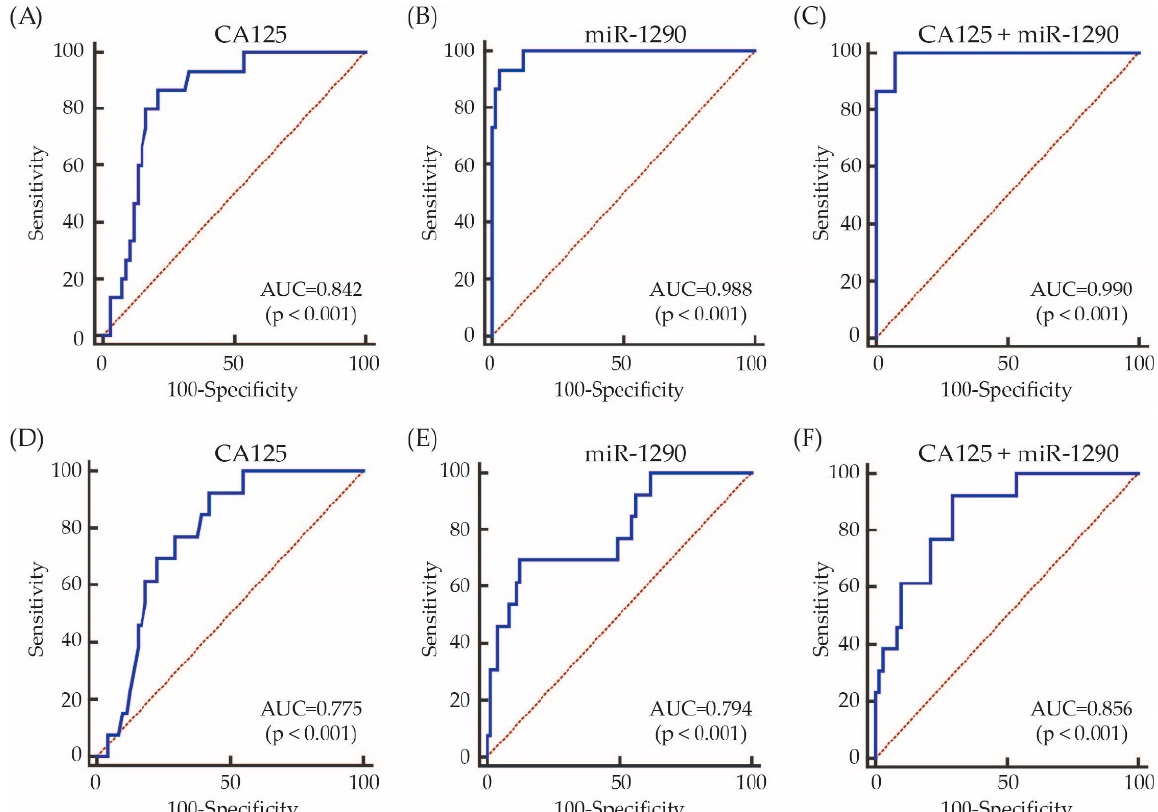
Figure 4. ROC curves for the identification of patients with EOC vs. benign ovarian neoplasm controls based on the expression of CA125, miR-1290, and the combination of both. The AUC values are shown on the graphs. ( A–C ) FFPE, ( D – F ) Serum.